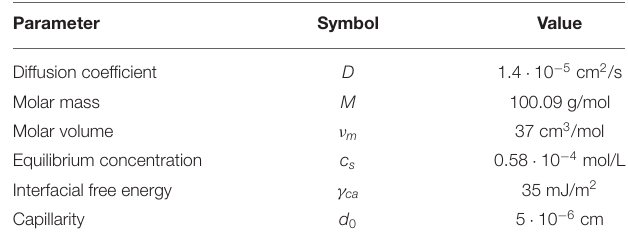
TABLE 1 | Parameters for the calcite mineral